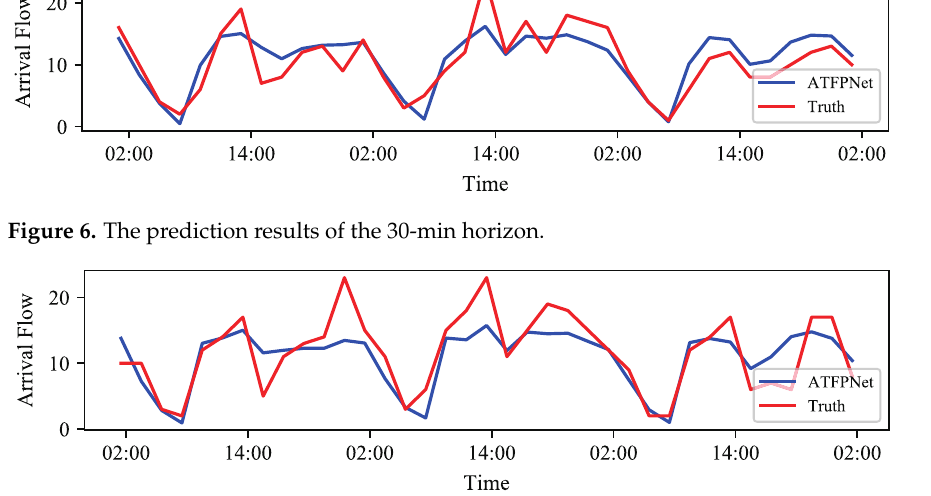
Figure 7. The prediction results of the 60-min horizon.